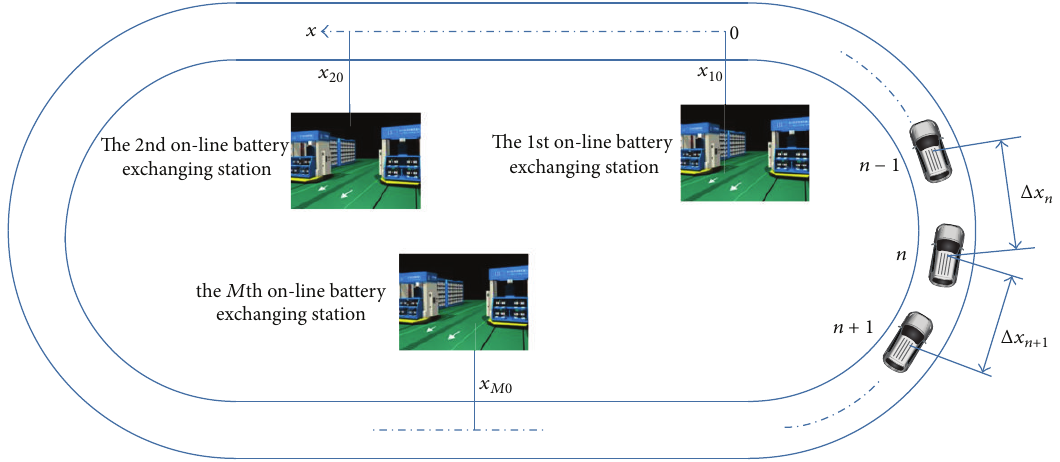
Figure 1: The car-following model for electric vehicle on a road with on-line charging